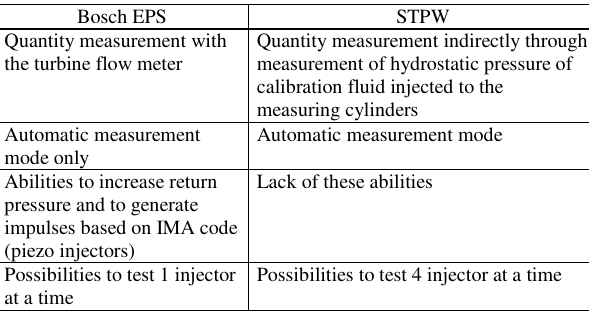
Fig. 7. EM test (actuation time 500 µs, pressure 80 MPa)